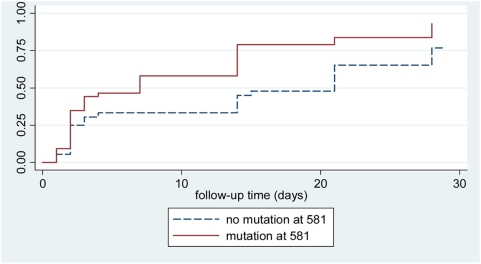
Cumulative proportions of treatment failure of Sulphadoxine-Pyrimethamine in symptomatic 6–59 month old children with malaria parasites carrying or not-carrying the A581G mutation in the dhps gene at enrolment.Unadjusted effect dhps gene mutation at 581, p-value = 0.012.